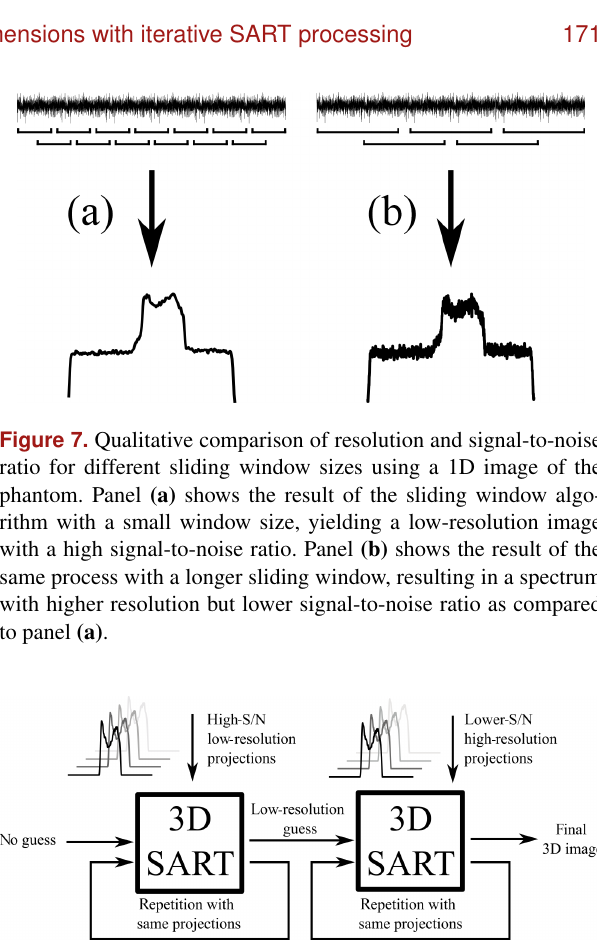
Figure 8. Iterative 3D SART reconstruction. The first 3D SART re- construction uses no initial guess and reconstructs a low-resolution image with a high signal-to-noise ratio. This intermediate result is used as the initial guess for the second 3D SART reconstruction, yielding the final reconstructed image. Each 3D SART reconstruc- tion is repeated multiple times with the same